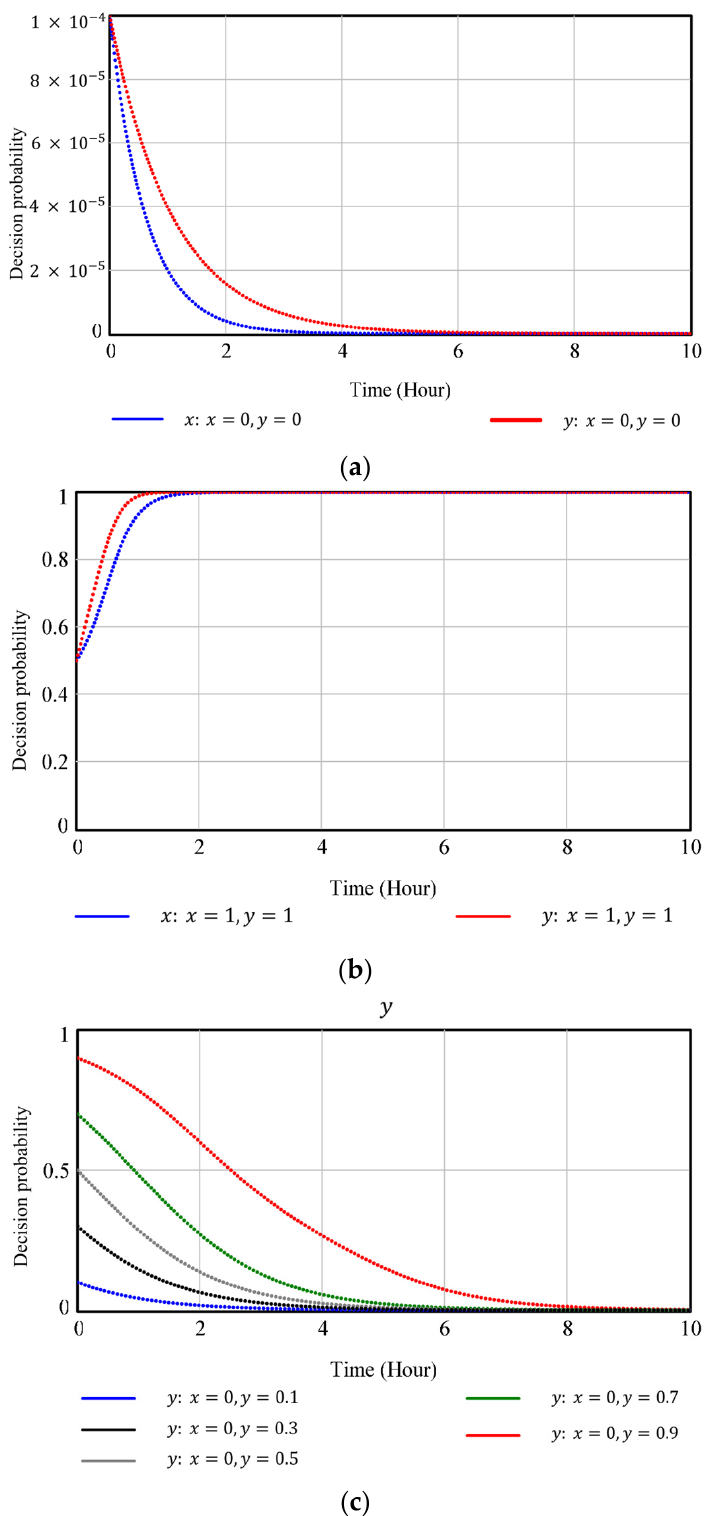
Figure 7. ( a ) The dynamic diagram to strategy (0,0); ( b ) the dynamic diagram to strategy (1,1); ( c ) the dynamic diagram to strategy of x = 0, y = { 0.1,0.3,0.5,0.7,0.9 } . * Considering that dx / dt and dy / dt have to be explanatory, when performing the simulation, we take the initial state ( x = 0.0001, y = 0.0001), which is close to 0. Similarly, the initial state ( x = 0.9999, y = 0.9999) is set as